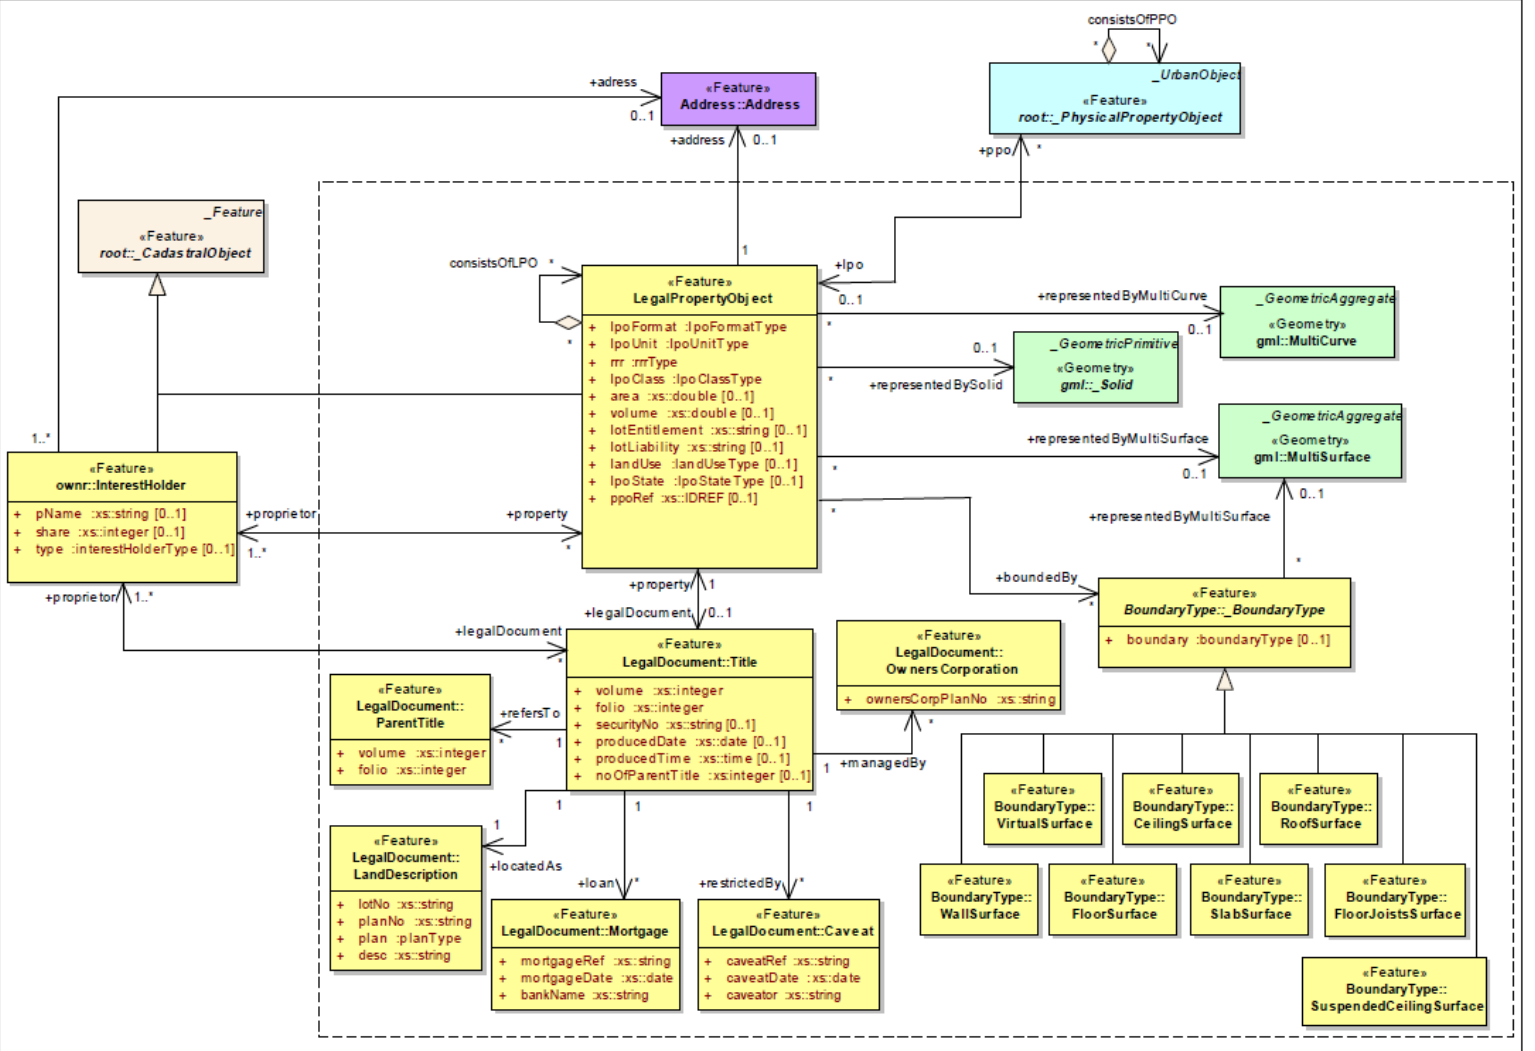
Figure 13. The UML diagram of 3DCDM LegalPropertyObject